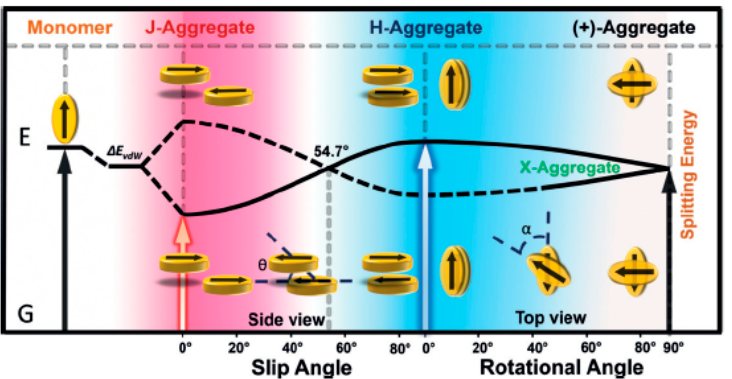
Figure 3. Schematic representation of splitting energy of different aggregates. Reproduced with permission from ref. [48]. Copyright 2018, Wiley-VCH.